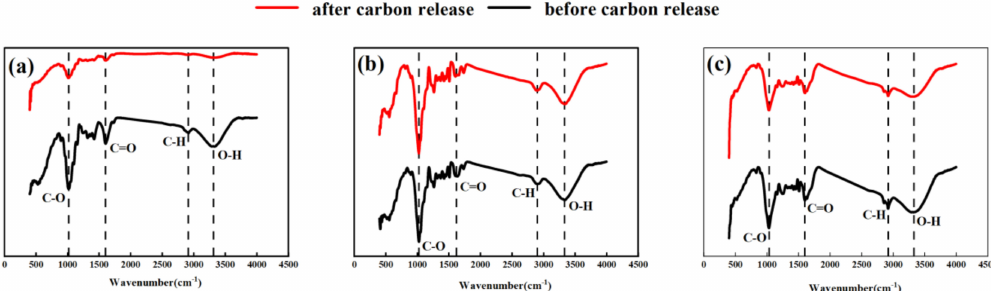
Figure 4. FTIR spectra before and after carbon release of different carbon sources. ( a ) peanut shell (PS); ( b ) sawdust (SD); ( c ) peat